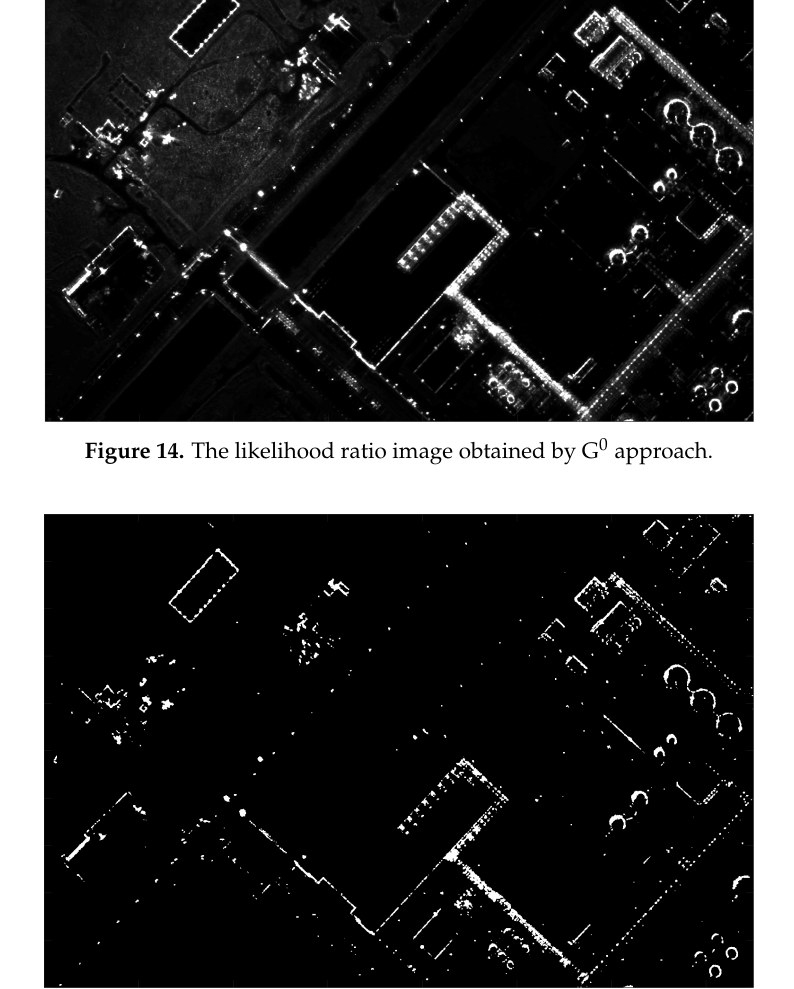
Figure 15. The binary image obtained by G 0